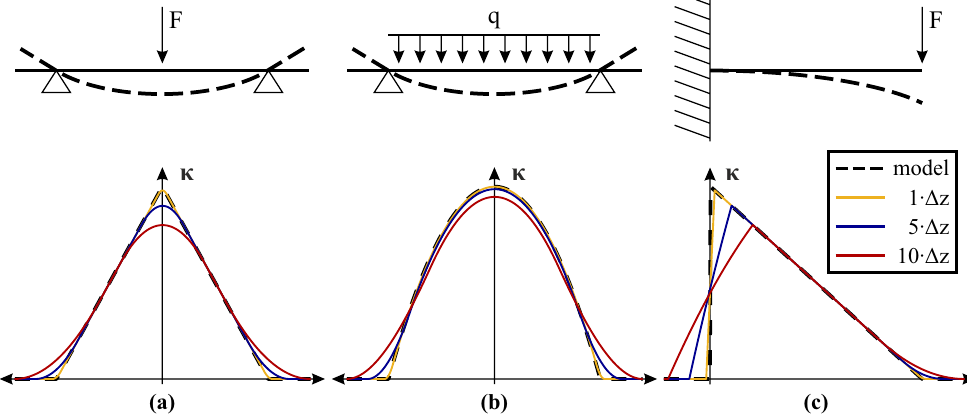
Figure 6. Theoretical analysis of spatial resolution impact on curvature determination: ( a ) Simply supported —single load (bi-linear distribution). ( b ) Simply supported —uniformly distributed load (parabolic distribution). ( c ) Cantilever —single load (linear